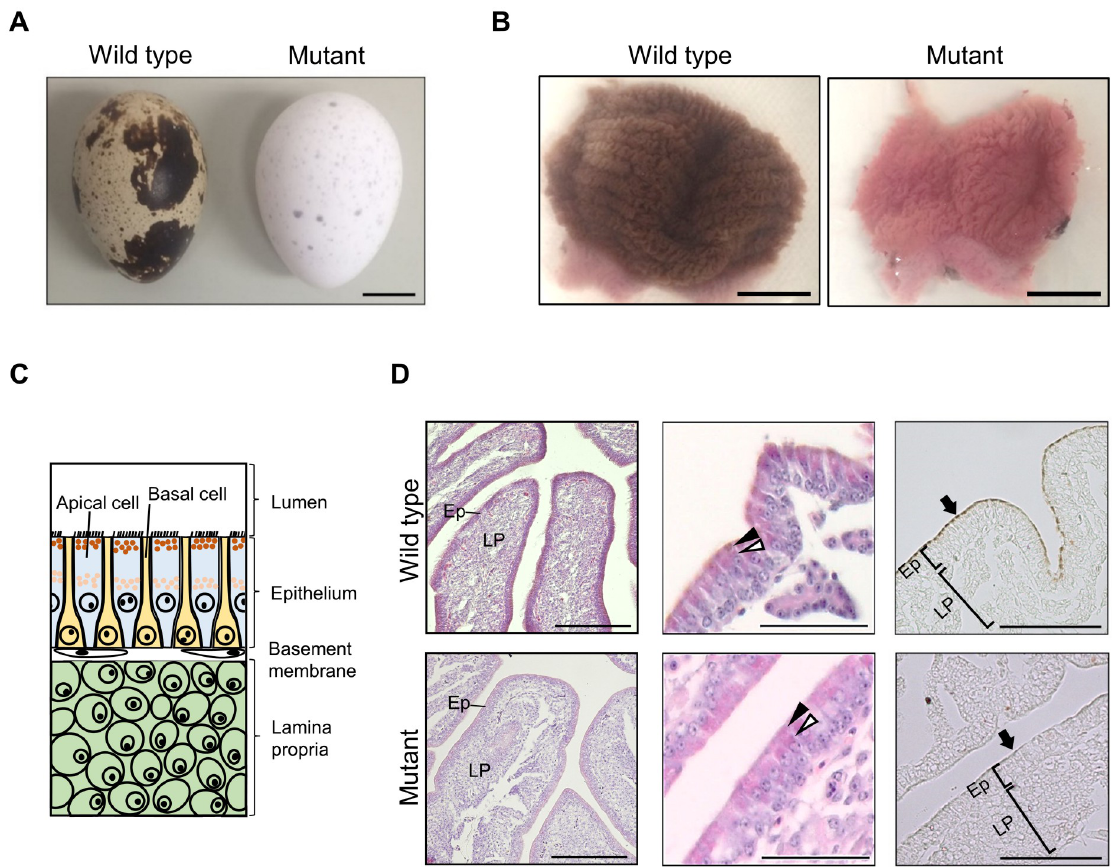
Fig 1. White eggshell phenotype and low accumulation of brown pigments in the uterine mucosa of the mutant quail. (A) Wild-type and mutant white eggs. (B) Wild-type and mutant uteri were opened with the lumen side up. (C) Schematic diagram of the uterine mucosa. Epithelium of the uterine mucosa consists of alternatingly arranged apical and basal cells. Pigment granules containing protoporphyrin IX (PPIX) molecules accumulate in the luminal side of the cytoplasm of apical cells before secretion. Lamina propria is located on the inner side of the uterine mucosa. (D) Sections of uterine mucosae obtained from wild-type and mutant quails just before pigment secretion (left and middle panels, HE staining; right panels, no staining). Ep and LP indicate epithelium and lamina propria, respectively. Brown pigments accumulated in the epithelium of the uterine mucosa of the wild-type quail, but not in that of the mutant quail (left panels). Higher- magnification images of mucosal folds (middle panels) indicate that brown pigment granules accumulated in the wild-type apical cells, but not in the mutant apical cells (black arrowheads); however, pink-colored, eosinophilic granules accumulated in the luminal side of the mutant apical cells. Eosinophilic granules also accumulated more centrally in both the wild-type and mutant apical cells (white arrowheads). Sections without staining clearly demonstrate that brown pigments were accumulated in the luminal side of the apical cells (arrows) of the wild-type quail, but not in the apical cells of the mutant quail. Scale bars: 1 cm in (A, B), 100 μ m in